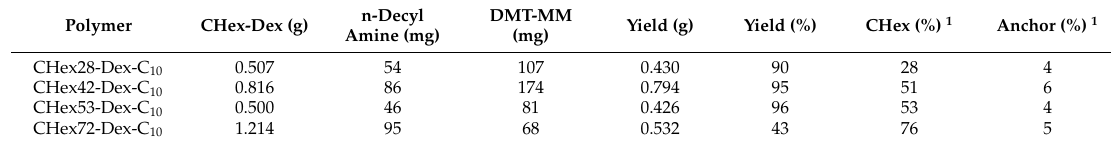
Table 2. Synthesis of CHex-Dex-C 10 .